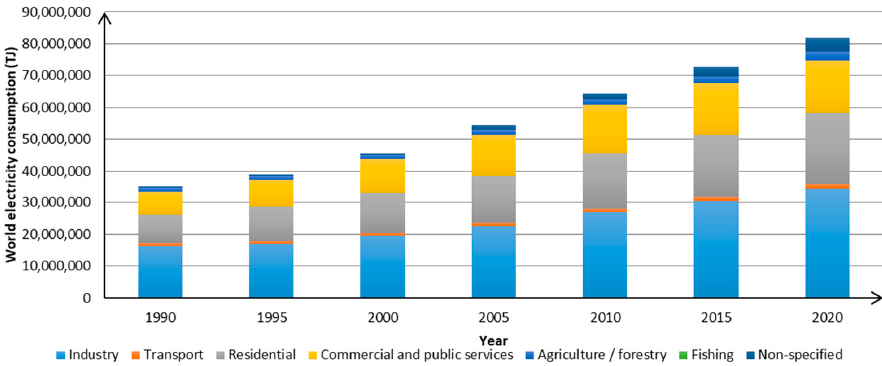
Figure 1. Global electricity consumption by sector from 1990 to 2020 [5].